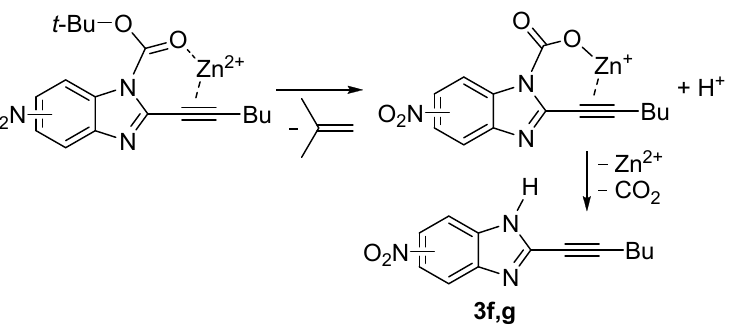
Scheme 3. Formation of byproducts 3f and 3g (Table 2, entries 6 and 7) by Boc deprotection of nitro-substituted substrates 1f and 1g , competitive with heterocyclization.